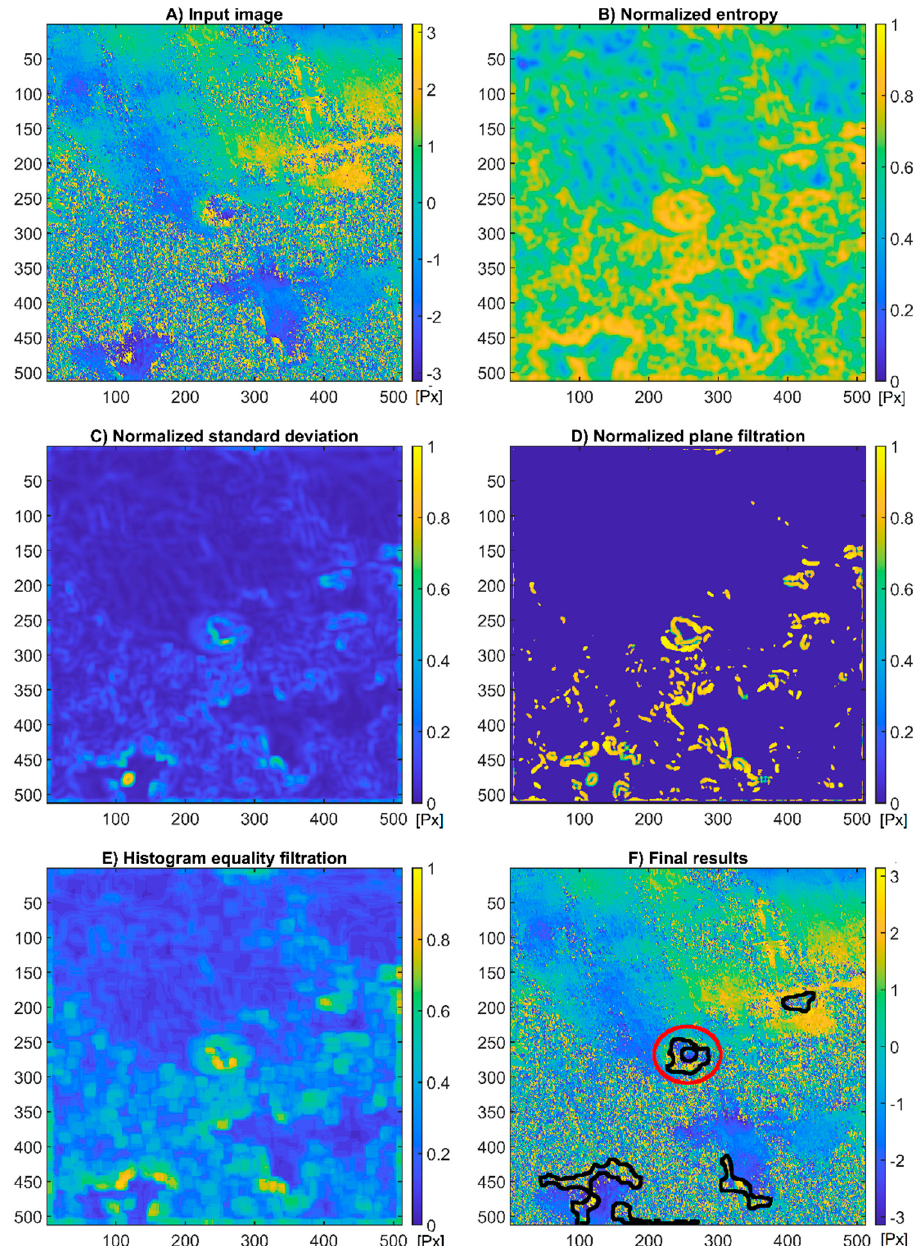
Figure 7. Efficiency of subsidence detection algorithm with a particular focus on the results of its particular operations. The interferogram computed from the radar images recorded on 21 July 2017 and 2 August 2017 for the area of the Upper Silesian Coal Basin, Poland (Sentinel-1A, descending).